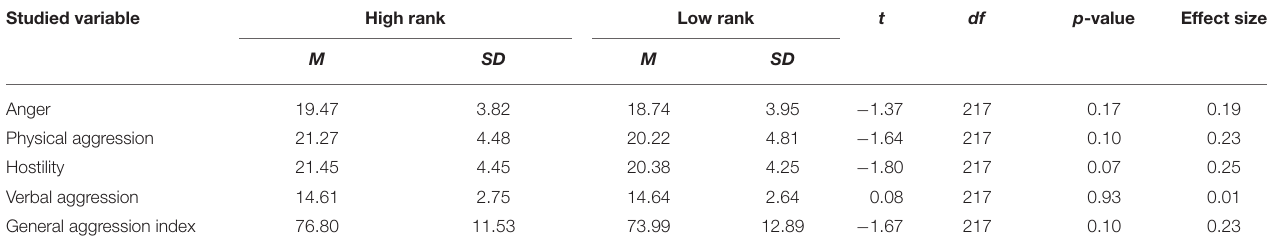
TABLE 6 | The level of aggression dimensions depending on the training rank. Studied